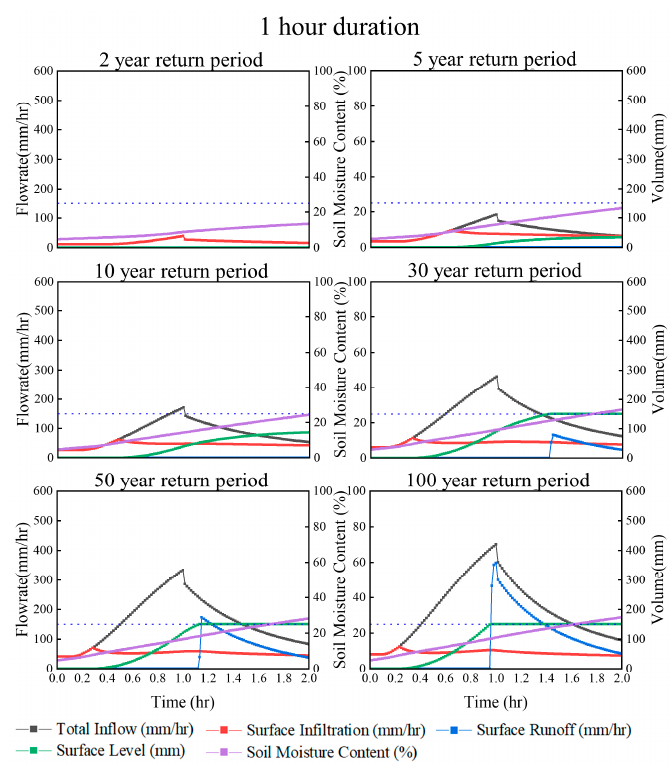
Figure 8. SWMM detailed reports on rain gardens in 1 h rainfall